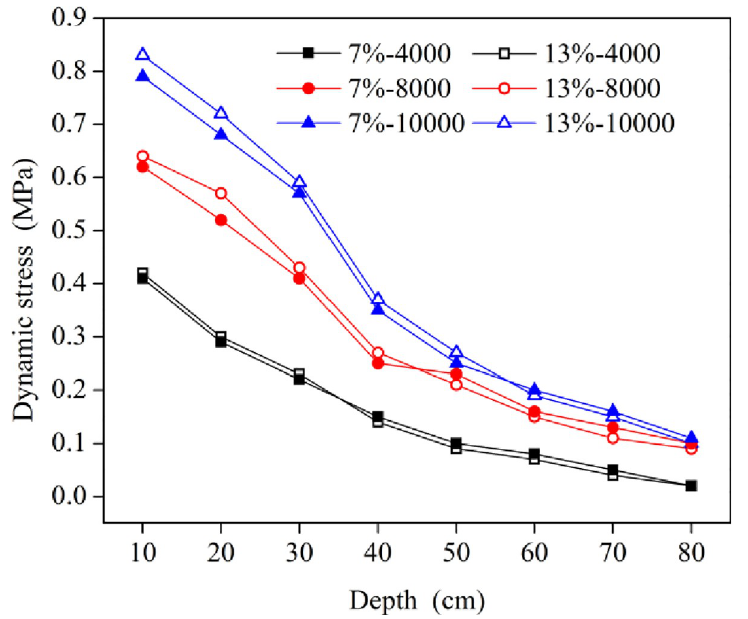
Fig 9. Variation curves of the dynamic stress verses different